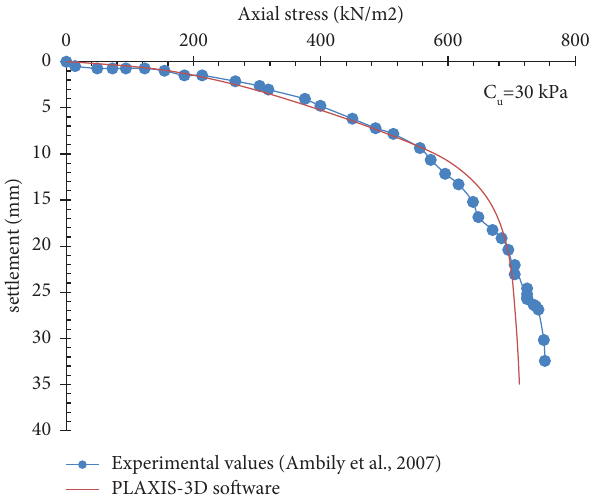
Figure 4: Validation of the axial stress versus settlement graph by Ambily and Gandhi [40].